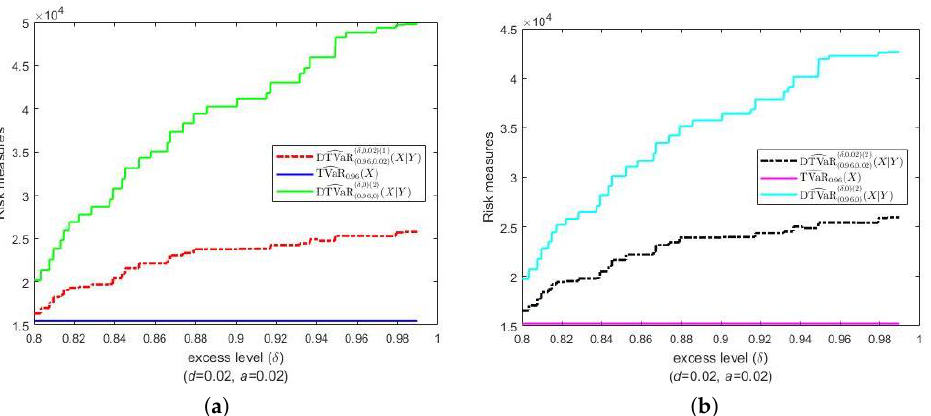
( δ ,0.02 )( n ) of claim amount associated with vehicle value, along with ( 0.96,0.02 ) ( δ ,0 )( n ) and TVaR 0.96 for ( a ) n = 1 and ( b ) n = 2. ( 0.96,0 )